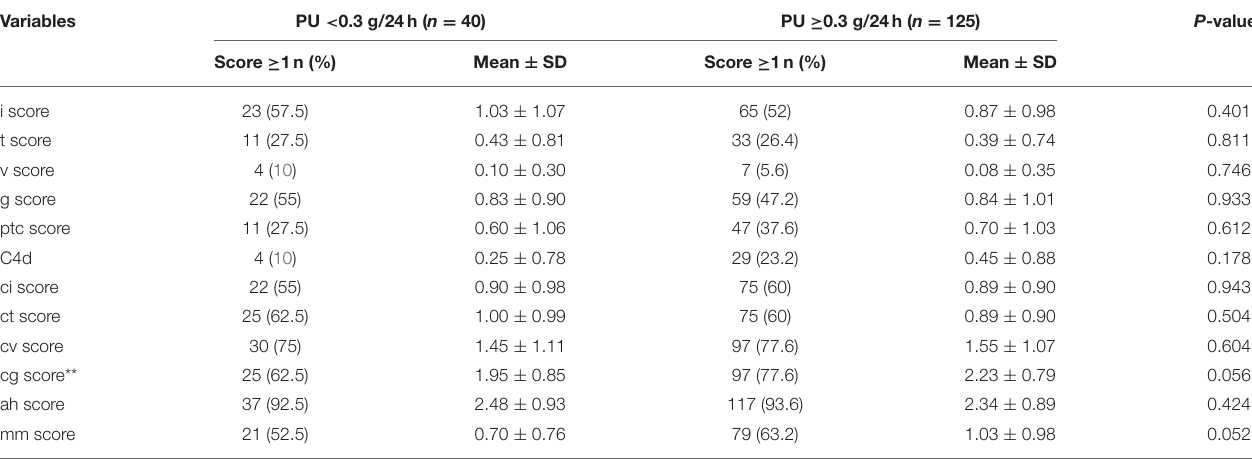
TABLE 3 | Histologic characteristics of enrolled biopsies.